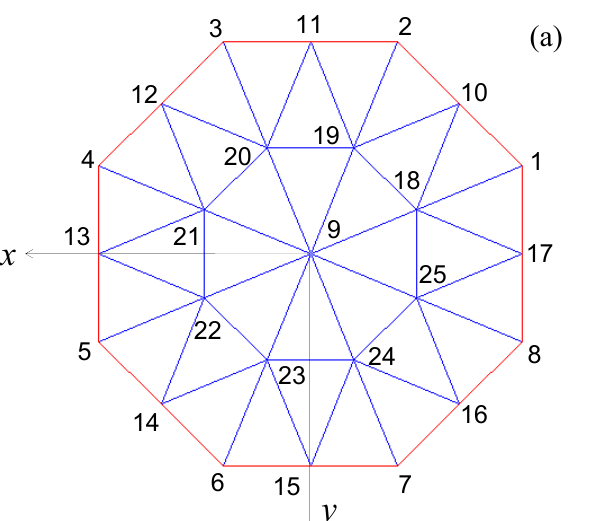
Figure 8 . (a) Node numbering for the 32 CST finite element mesh used to calculated the system response, (b) spatial distribution of the considered forcing